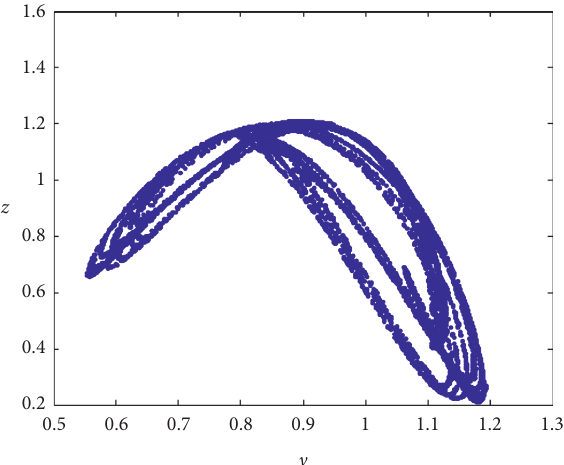
Figure 29: y - z phase diagram which denotes that the system is chaotic when c � 0.8.